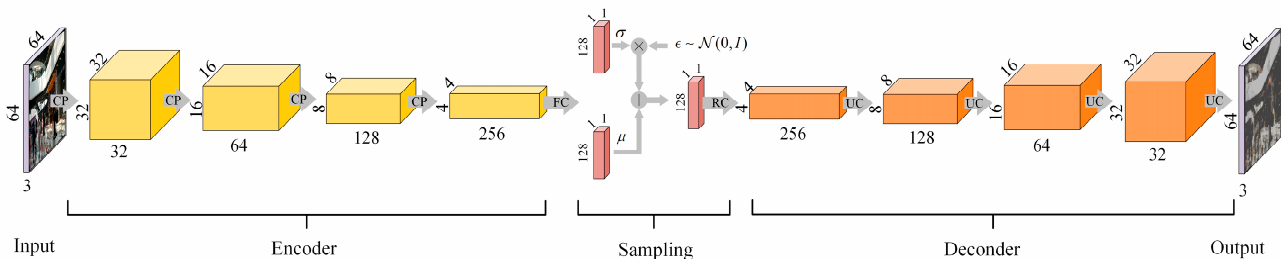
Figure 3. Structure of the designed variational autoencoder. CP represents Convolution + Pooling, FC represents Fully Connected, RC represents Reshape + Convolution, UC represents Upsampling + Convolution. The mean µ of latent variable forms our global descriptor.